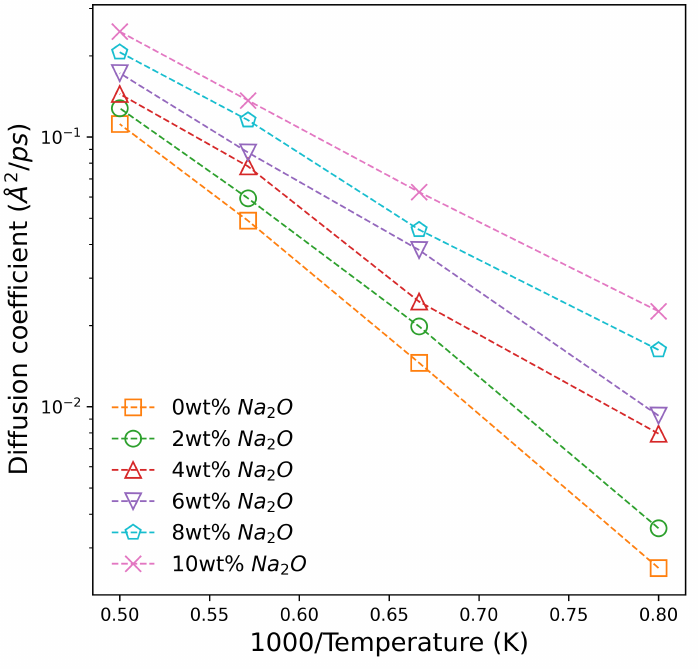
Figure 7. Simulated diffusion coefficient as a function of 1000 different Na 2 O weight